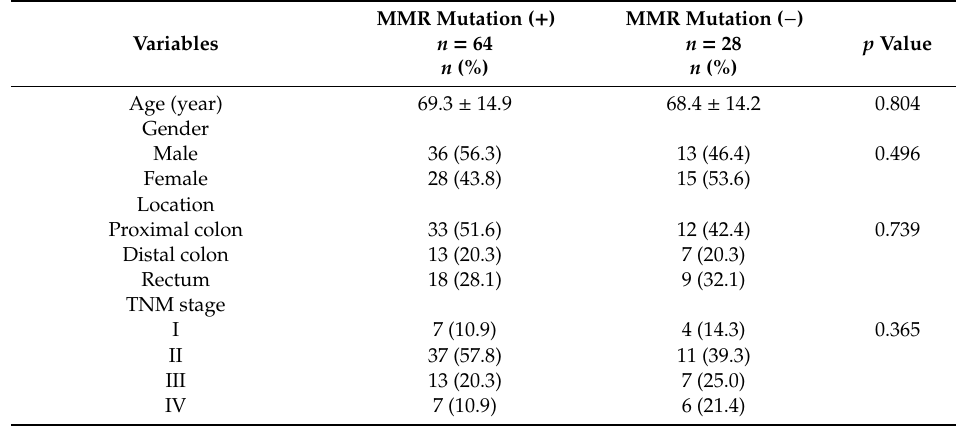
Table 3. The clinicopathological features between CRC patients with and without mismatch repair (MMR)